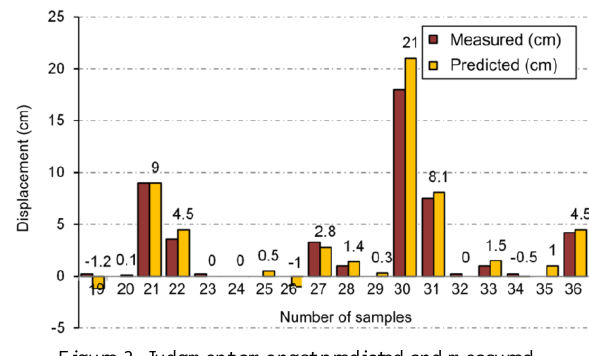
Figure 3. Judgment amongst predicted and measured deformation for training second 18 data locations